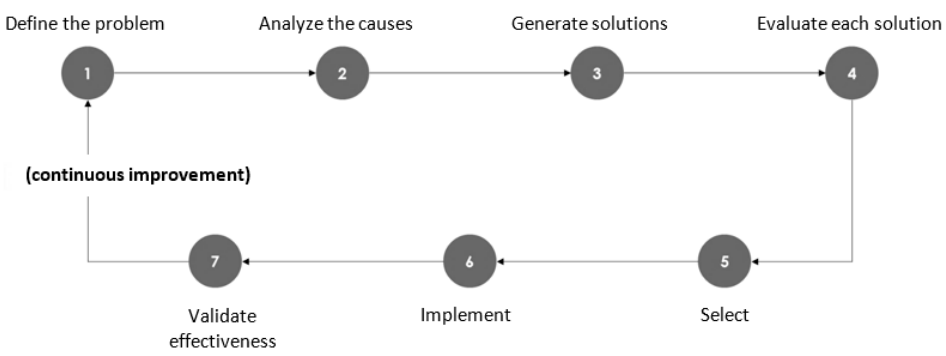
Figure 8. Problem solving process as Workflow (authors).